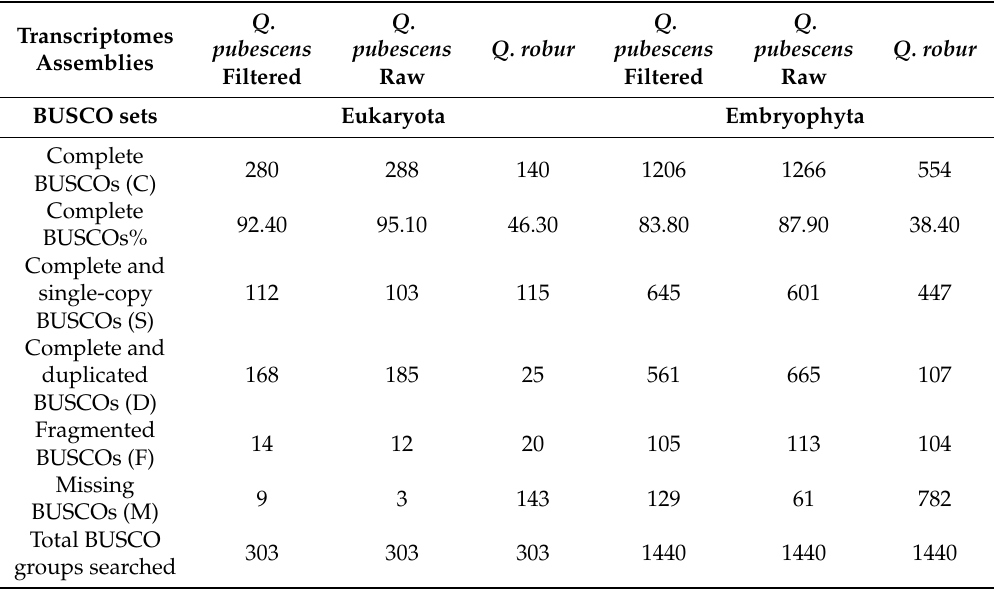
Table2. BUSCOrunforgenome-guideddenovotranscriptomeassemblyof Q.pubescens andcomparison with Q. robur de novo assembly (OCV4_assembly_final.fas)